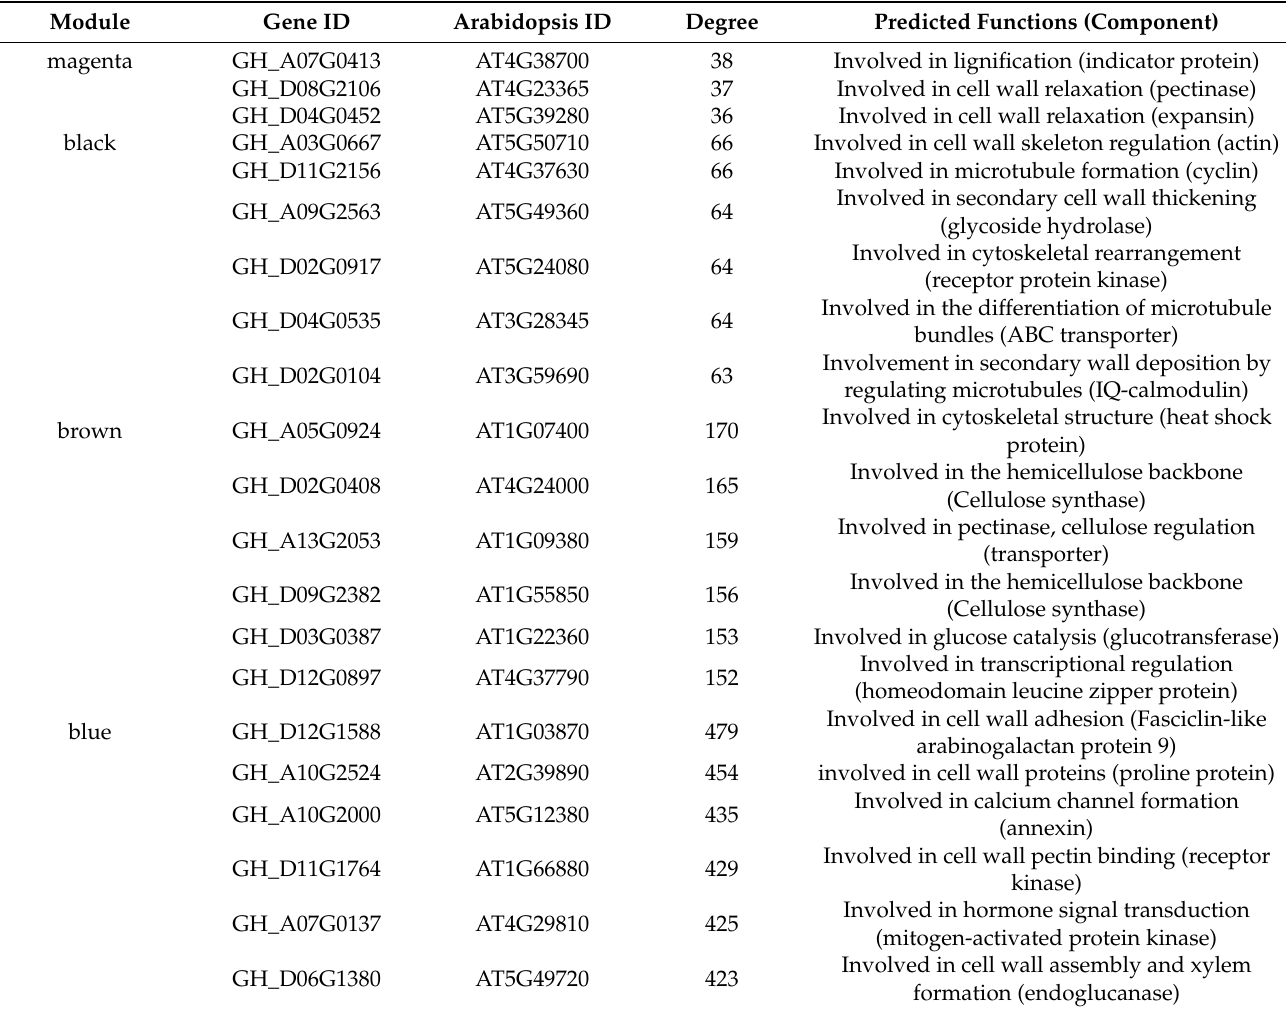
Table 2. Hub genes and